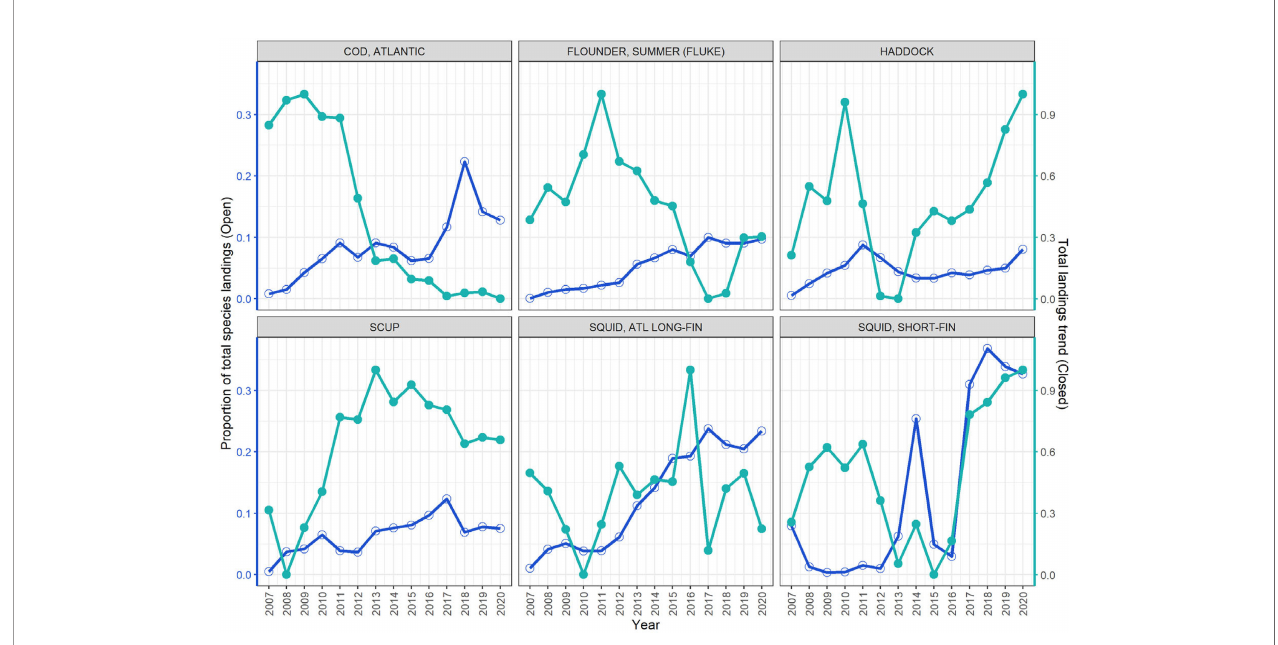
FIGURE 6 | The proportion of six species ’ regional commercial landings reported through Study Fleet (dark blue open circles), relative to the trend in total commercial landings of the species (light blue closed circles).